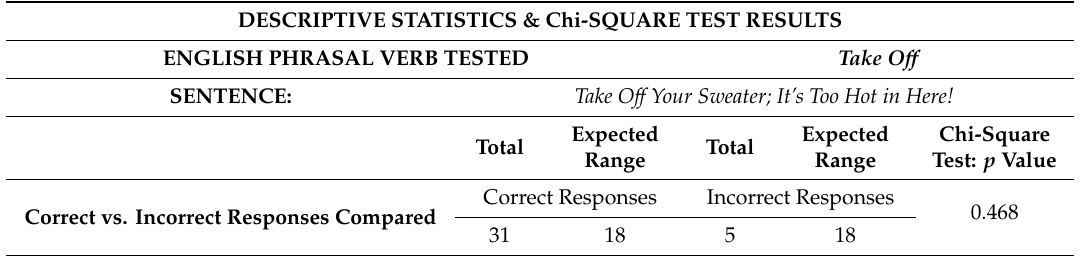
Table 10. p -value for take o ff .